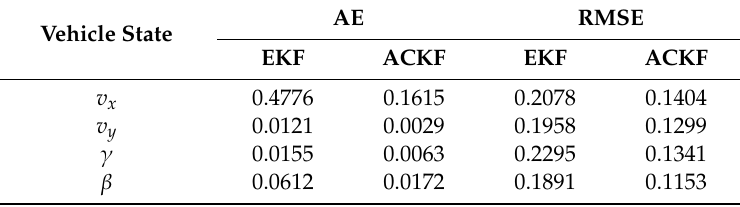
Figure 8. Comparison of estimation effects in road test: ( a ) Longitudinal vehicle speed; ( b ) lateral vehicle speed; ( c ) yaw rate; ( d ) sideslip angle. Table 4. Quantitative analysis of estimation effects in road test.